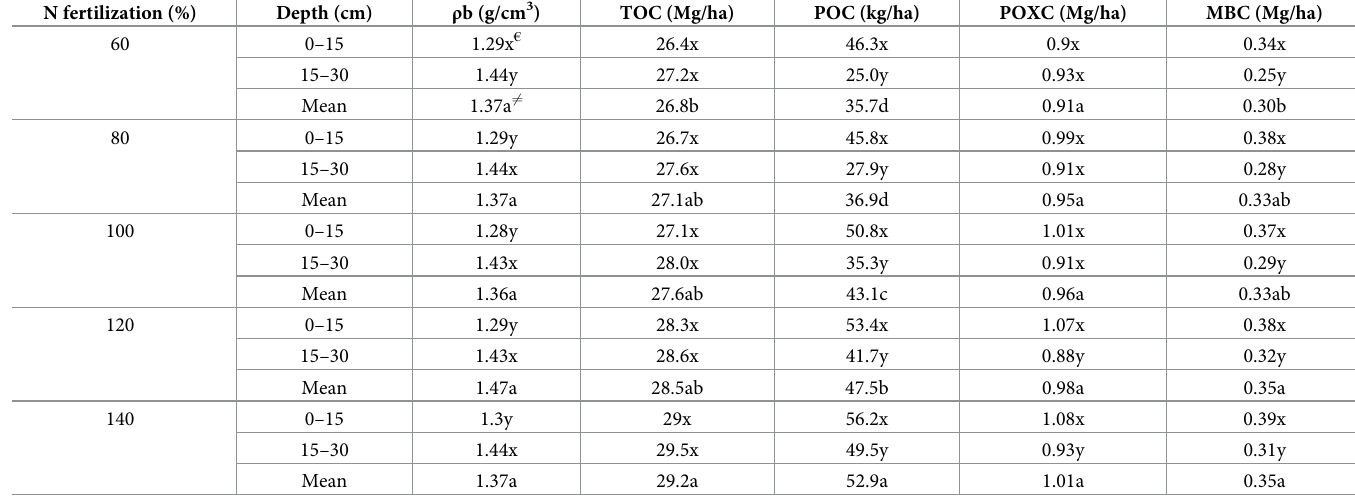
Table 3. Impact of nitrogen fertilization on soil bulk density and depth distribution of total organic carbon, particulate organic matter, particulate organic carbon, and permanganate oxidizable carbon stocks. N fertilization